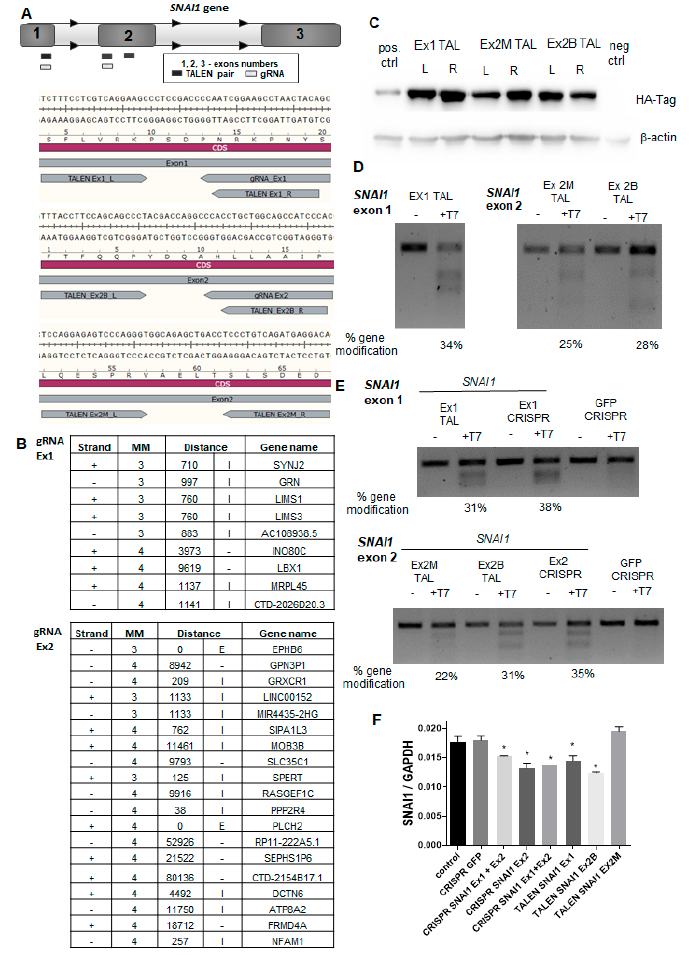
Figure 1. The design and cleavage activity of transcription activator-like effector nucleases (TALEN) and clustered regularly interspaced short palindromic repeats (CRISPR)/Cas9 nucleases targeting the SNAI1 gene. ( A ) Scheme presenting TALEN pairs and CRISPR/Cas9 nucleases targeting SNAI1 . ( B ) Analysis of possible o ff -targets of gRNA1 and gRNA2 was performed with online predictor